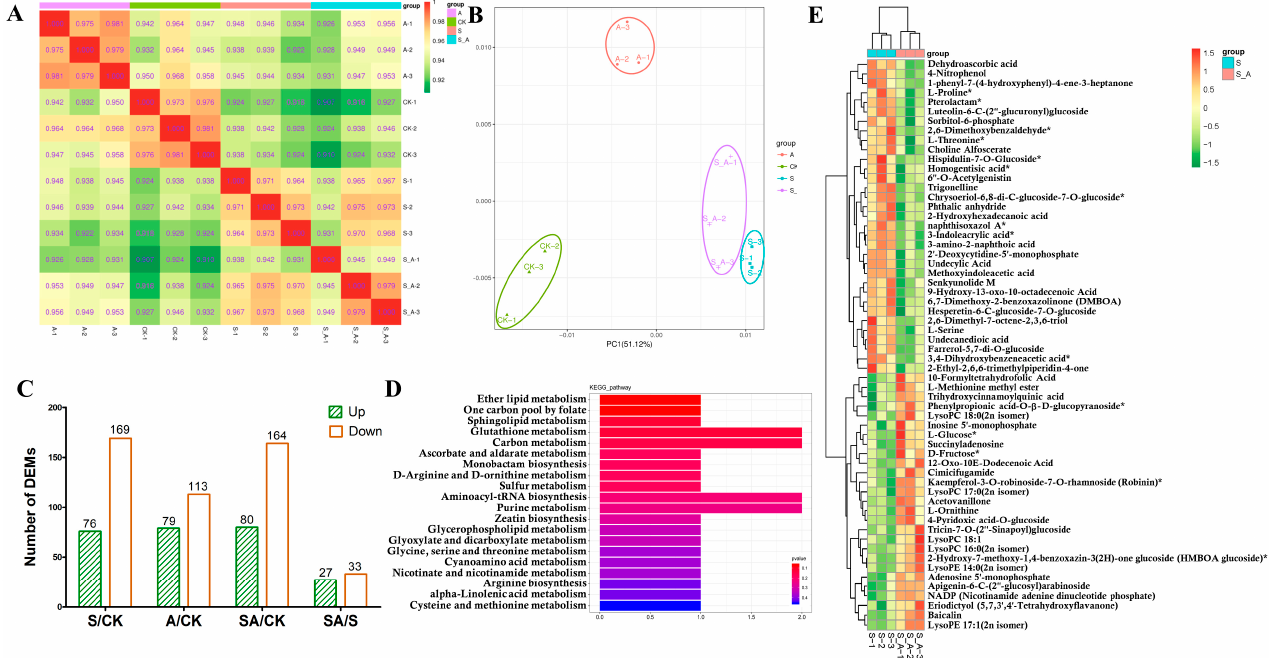
Figure 4. Metabolite profiling analysis of the C18 seedlings under salt (S), allantoin (A), salt + allantoin (SA), and control (CK) conditions. Correlation analysis of the biological samples for the four treatments ( A ). Principal component analysis of the metabolome data for the four treatments ( B ). Overview of the differentially abundant metabolites revealed by the S vs. CK, A vs. CK, SA vs. CK, and SA vs. S comparisons ( C ). Results of the KEGG enrichment analysis and a cluster heat map of the differentially abundant metabolites in the C18 seedlings revealed by the SA vs. S comparison ( D , E ). The * in E indicates that this metabolite is an isomer.